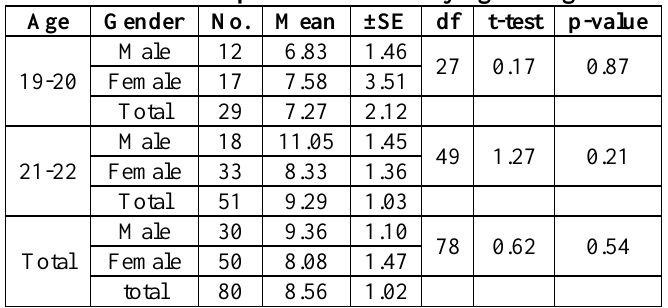
Table 1: Caries experience DMFS by age and gender